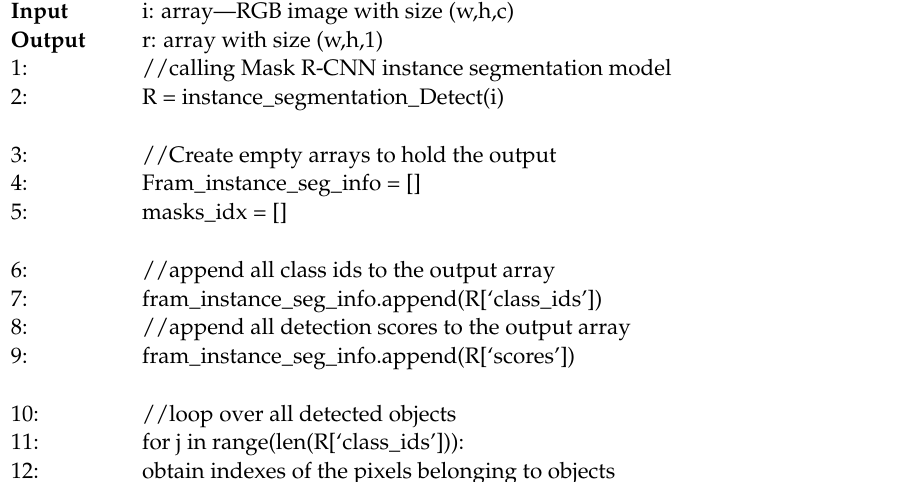
Figure 5. Instance segmentation objects’ masks and types encoded into a single 2D 1-channel array. Algorithm 1 : algorithm to encode instance segmentation masks and objects type Function